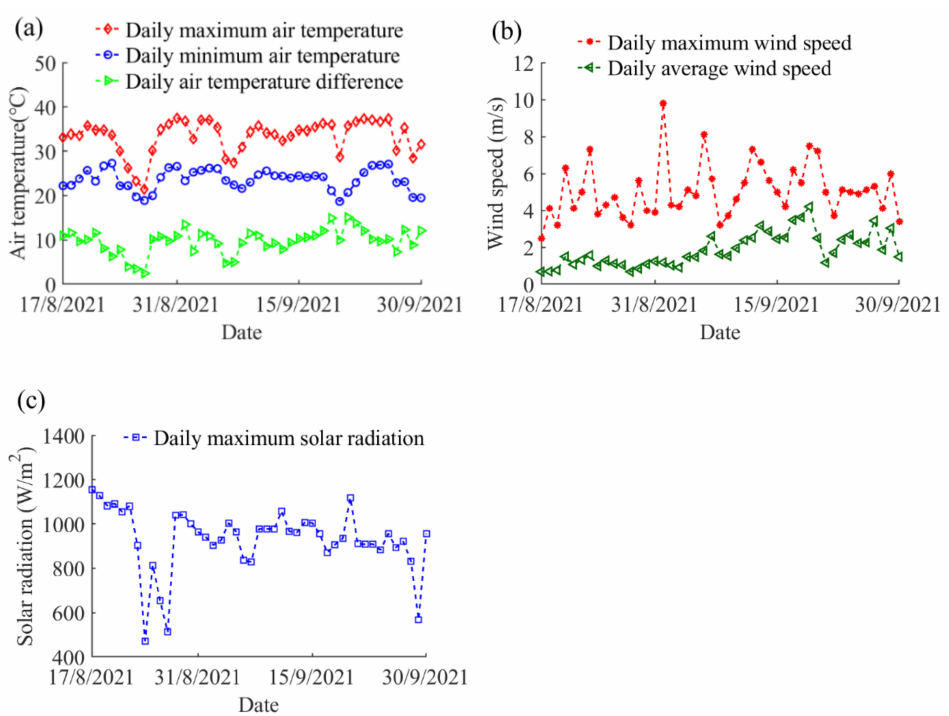
Figure 5. The recorded climatic data during the experimental period: ( a ) air temperature; ( b ) wind speed; and ( c ) solar